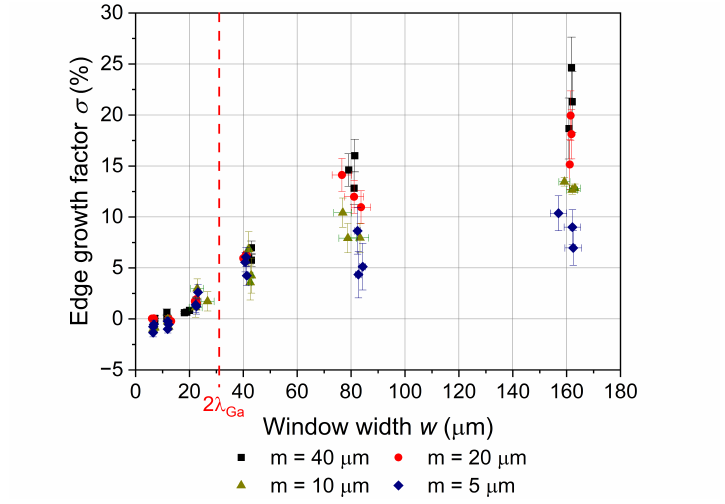
Figure 13. Edge growth factor as a function of window width σ = f ( w ) (layer thickness 500 nm). Uniform layer growth will be observed, provided that the distance between the mask center and window center will be smaller than the effective diffusion length